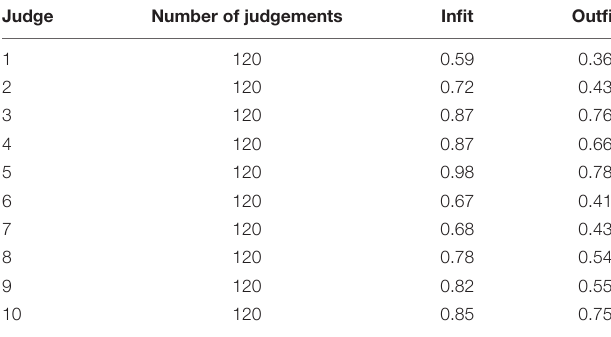
TABLE 1 | Judge fit: consistency with the Bradley–Terry